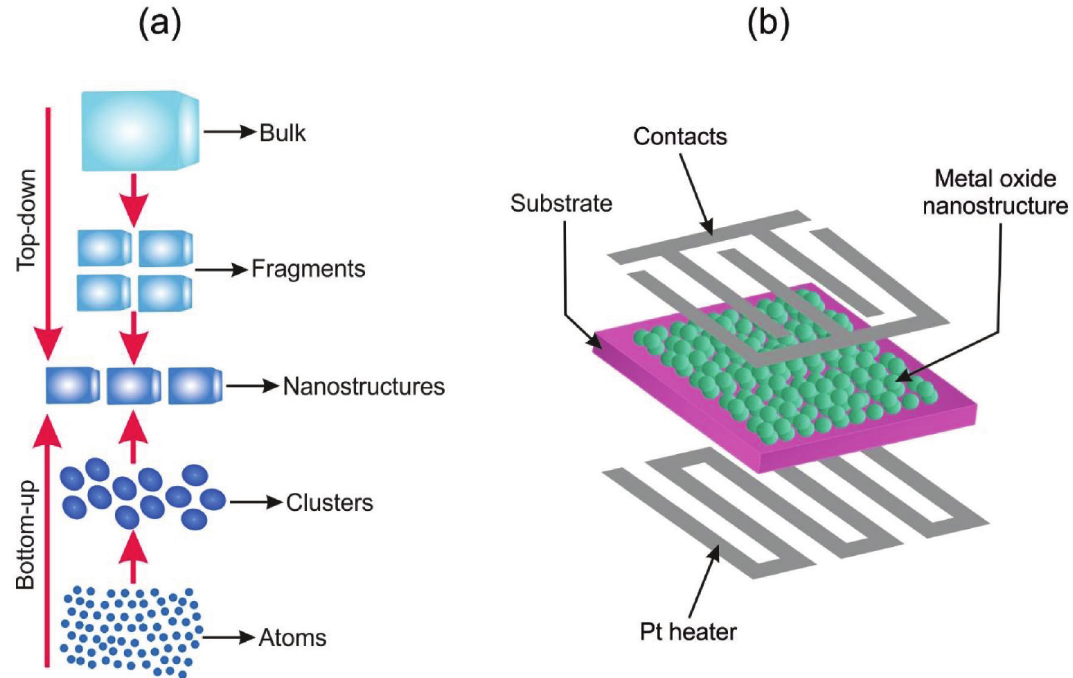
Figure 1: (a) The schematic representation of the top-down and bottom-up approaches for the fabrication of metal oxide nanostructures. Reprinted from Ref. [67]. (b) The schematic of a chemiresistive transducer (original image).